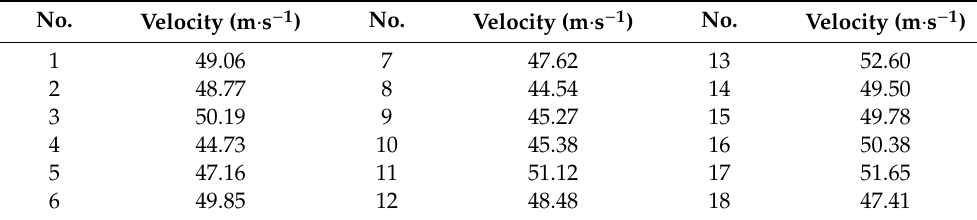
Table 9. Velocity of the pin-rod.